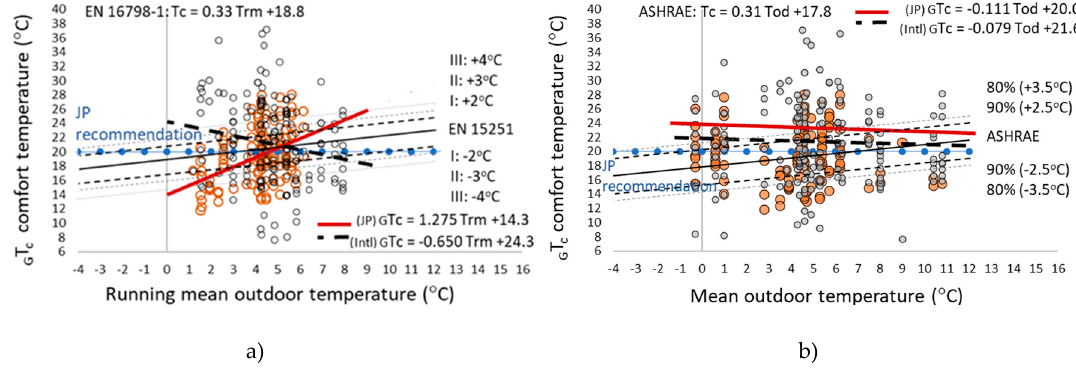
Figure 18. Comparison of comfortable temperature with standards: ( a ) EN 16798-1 and ( b ) ASHRAE.